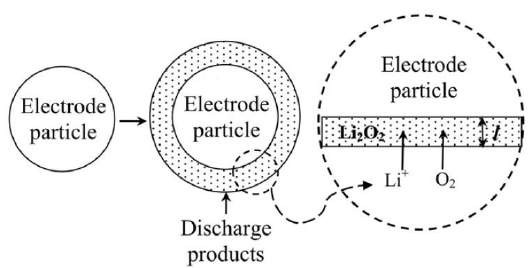
Figure 25. Schematic diagram of reactant transport inside the porous electrode and discharge product growth on the surface of spherical electrode particles. Reprinted from Sahapatsombut et al. [10], with permission from Elsevier.